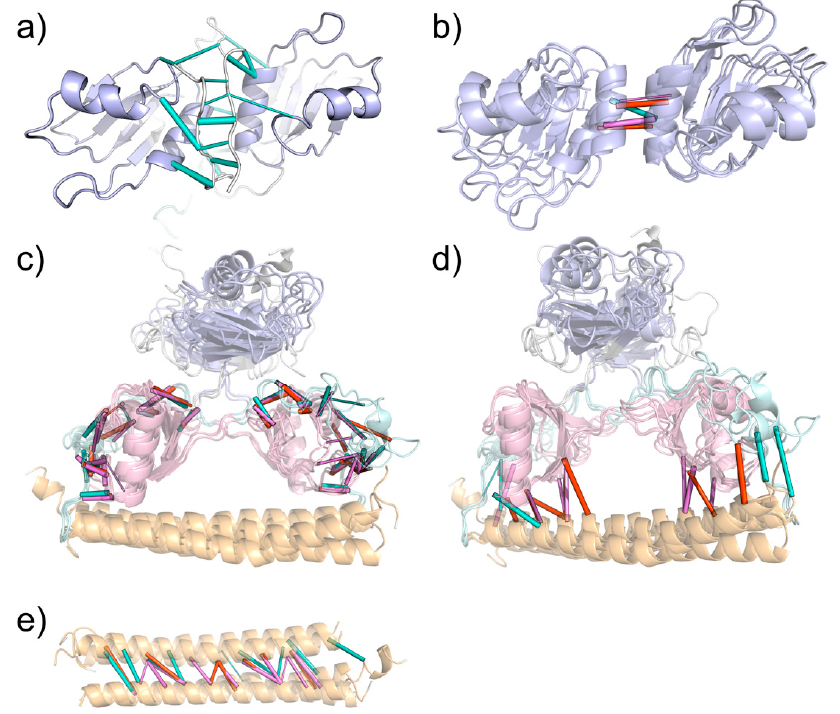
Figure 5. Molecular dynamics interactions network. ( a ) Beta-clasp interactions between N-termini in NONO::NONO. ( b ) Backbone-to-backbone interactions between RRM1s helix 2. ( c ) RRM2-NOPS interactions. ( d ) RRM2 and NOPS interactions with coiled-coil. ( e ) Coil-coil interactions. Cartoon colors: RRM1 (blue), RRM2 (pink), NOPS (light blue), coiled-coil (yellow). Interaction tube colors: NONO::SFPQ (red), NONO::NONO (cyan), SFPQ::SFPQ (magenta).